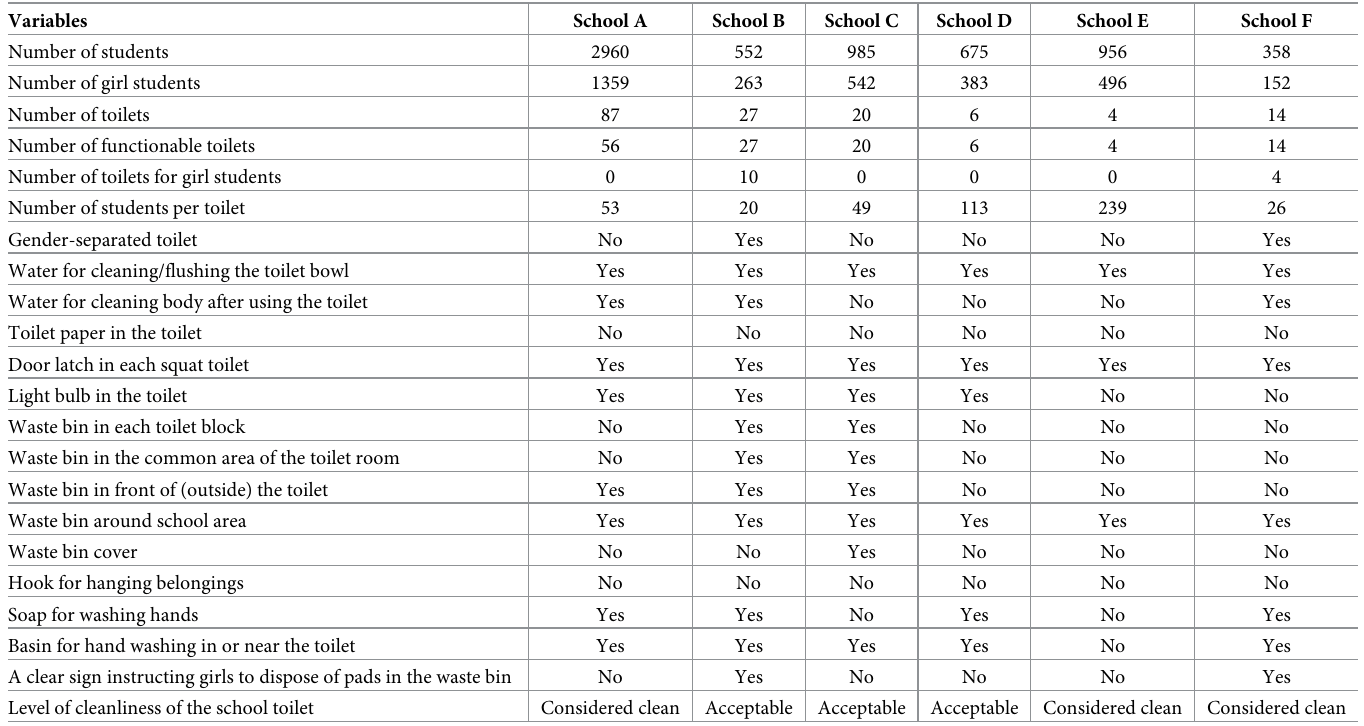
Table 5. Characteristics of school toilets at six schools in Luang Prabang